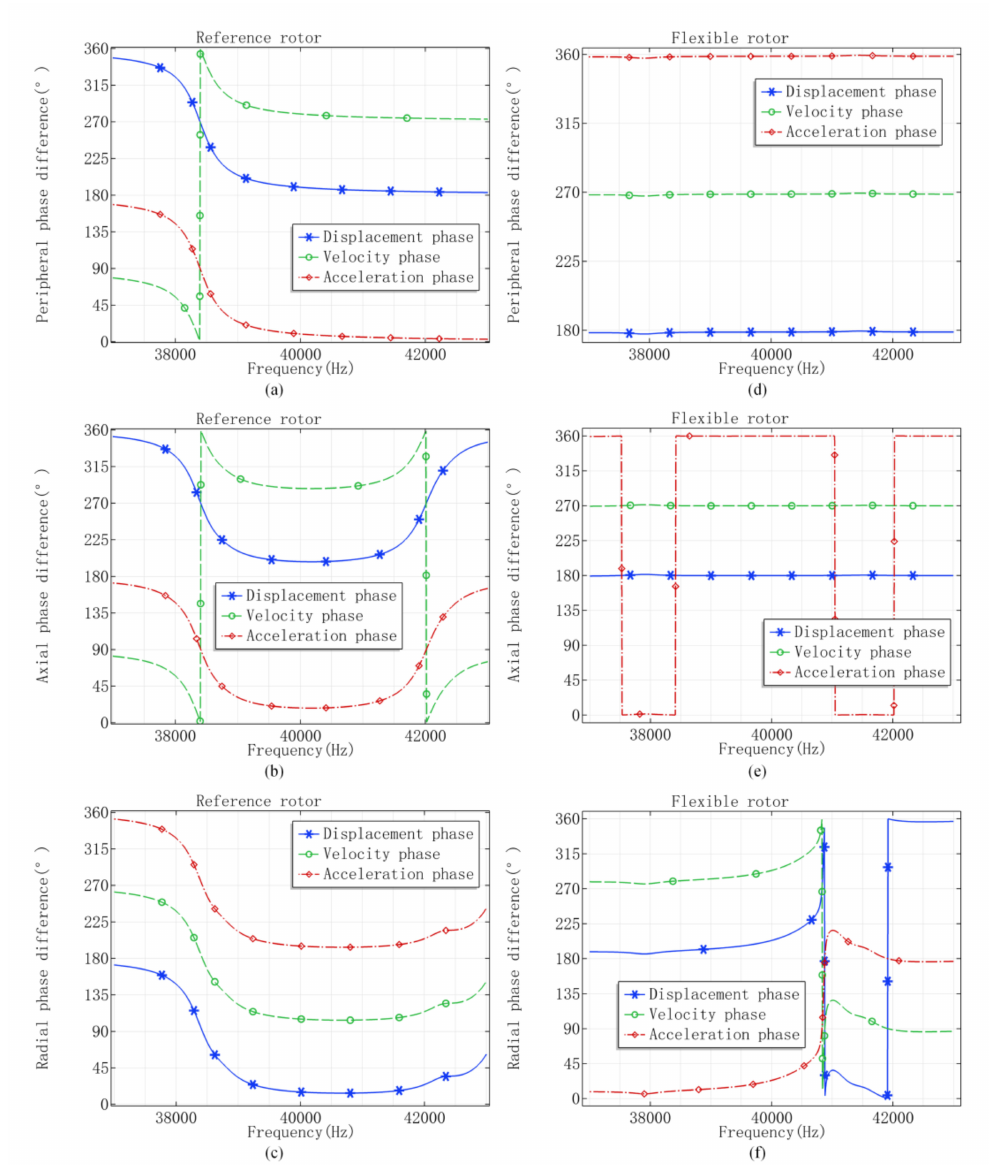
Figure 9. Variation of phase difference of reference rotor and flexible rotor as sweeping frequency. ( a ) Peripheral phase difference of reference rotor. ( b ) Axial phase difference of reference rotor. ( c ) Radial phase difference of reference rotor. ( d ) Peripheral phase difference of flexible rotor. ( e ) Axial phase difference of flexible rotor. ( f ) Radial phase difference of flexible